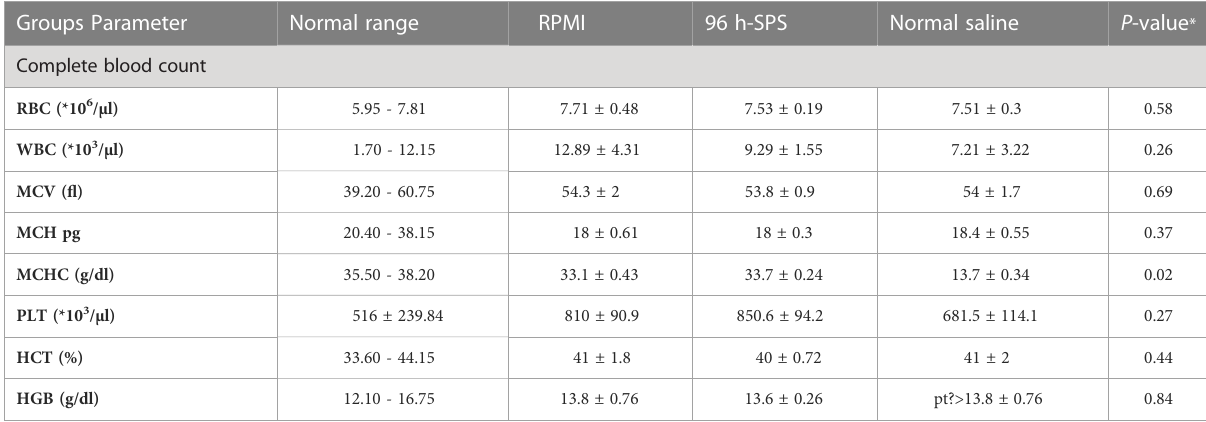
TABLE 1 The blood index of cancerous rats treated with RPMI, 96 h-SPS, and normal saline. Groups